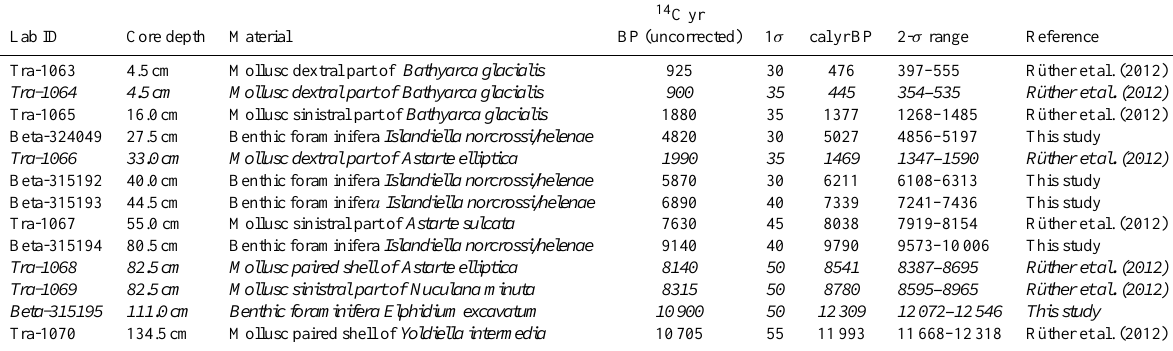
Table 1. AMS 14 C dates and calibrated radiocarbon ages of JM09-KA11-GC. The calibration is based on the Marine13 calibration curve (Reimer et al., 2013) and a regional 1 R of 67 ± 34. The dates which are not used in the final depth–age model are indicated in italics.